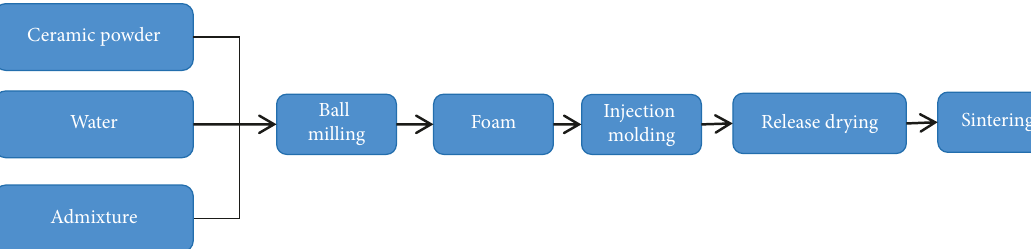
Figure 2: Process flow of preparing porous ceramics by the foaming